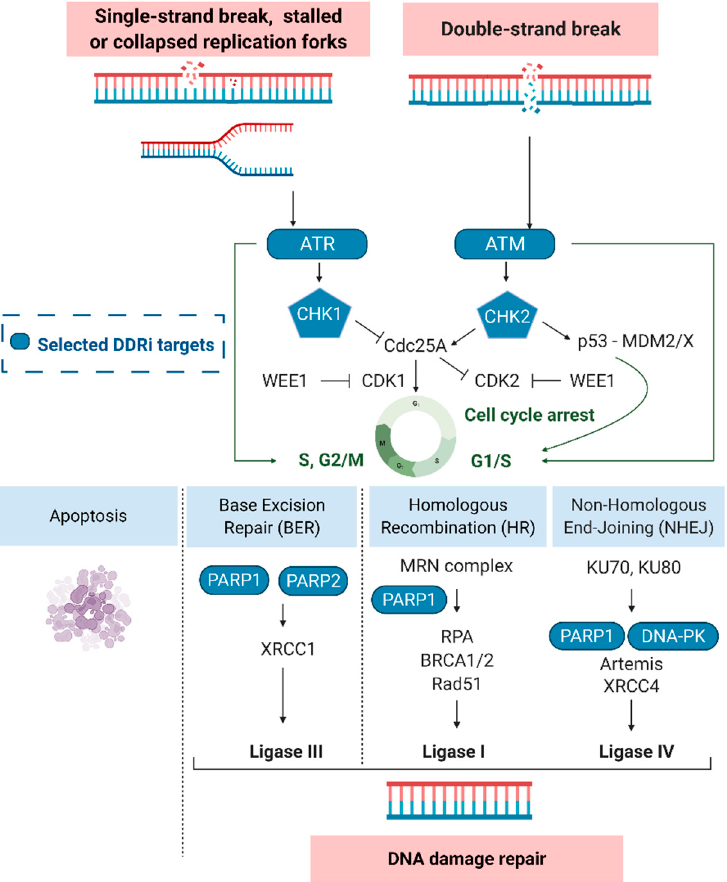
Figure 2. The DNA damage response and selected targets (blue). Ataxia-telangiectasia mutated (ATM), ATM-RAD3-related protein (ATR), cyclin-dependent kinase 1 (CDK1/2), checkpoint kinase-1 and -2 (CHK1/2), DNA-dependent protein kinase (DNA-PK), Mouse double minute 2/X homolog (MDM2/X), Nbs1/hMre11/hRad50 (MRN complex), poly (ADP-ribose) polymerase-1 and -2 (PARP), replication protein A (RPA), X-ray repair cross-complementing protein 4 (XRCC4).